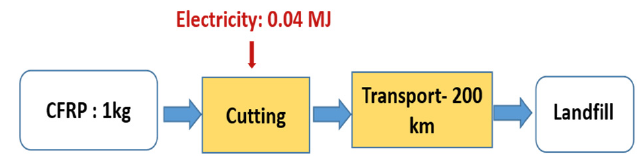
Figure 9. Flow diagram of landfill process.